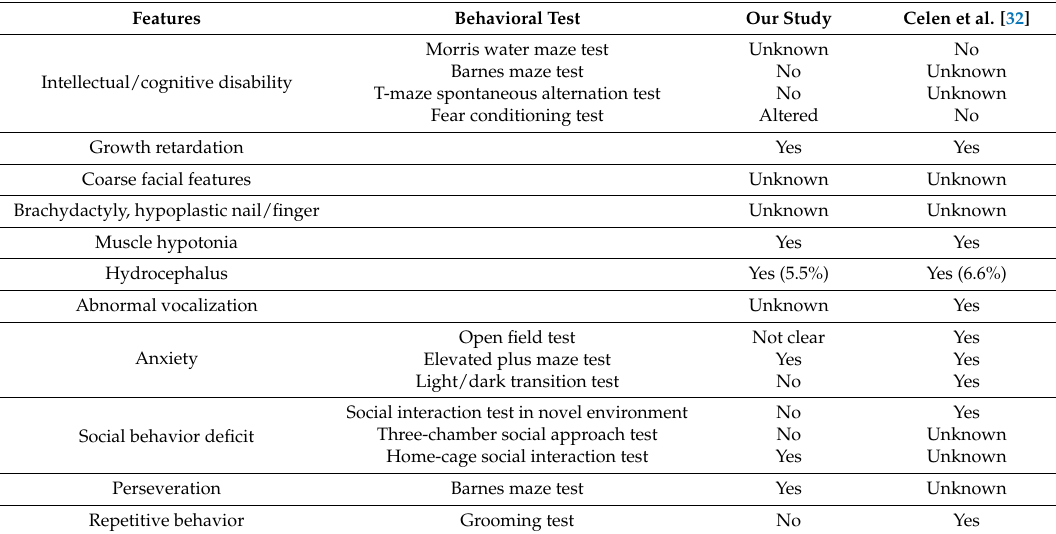
Table 1. Comparison of our mice with those of previously reported Arid1b haploinsufficient mice (Celen et al., 2017